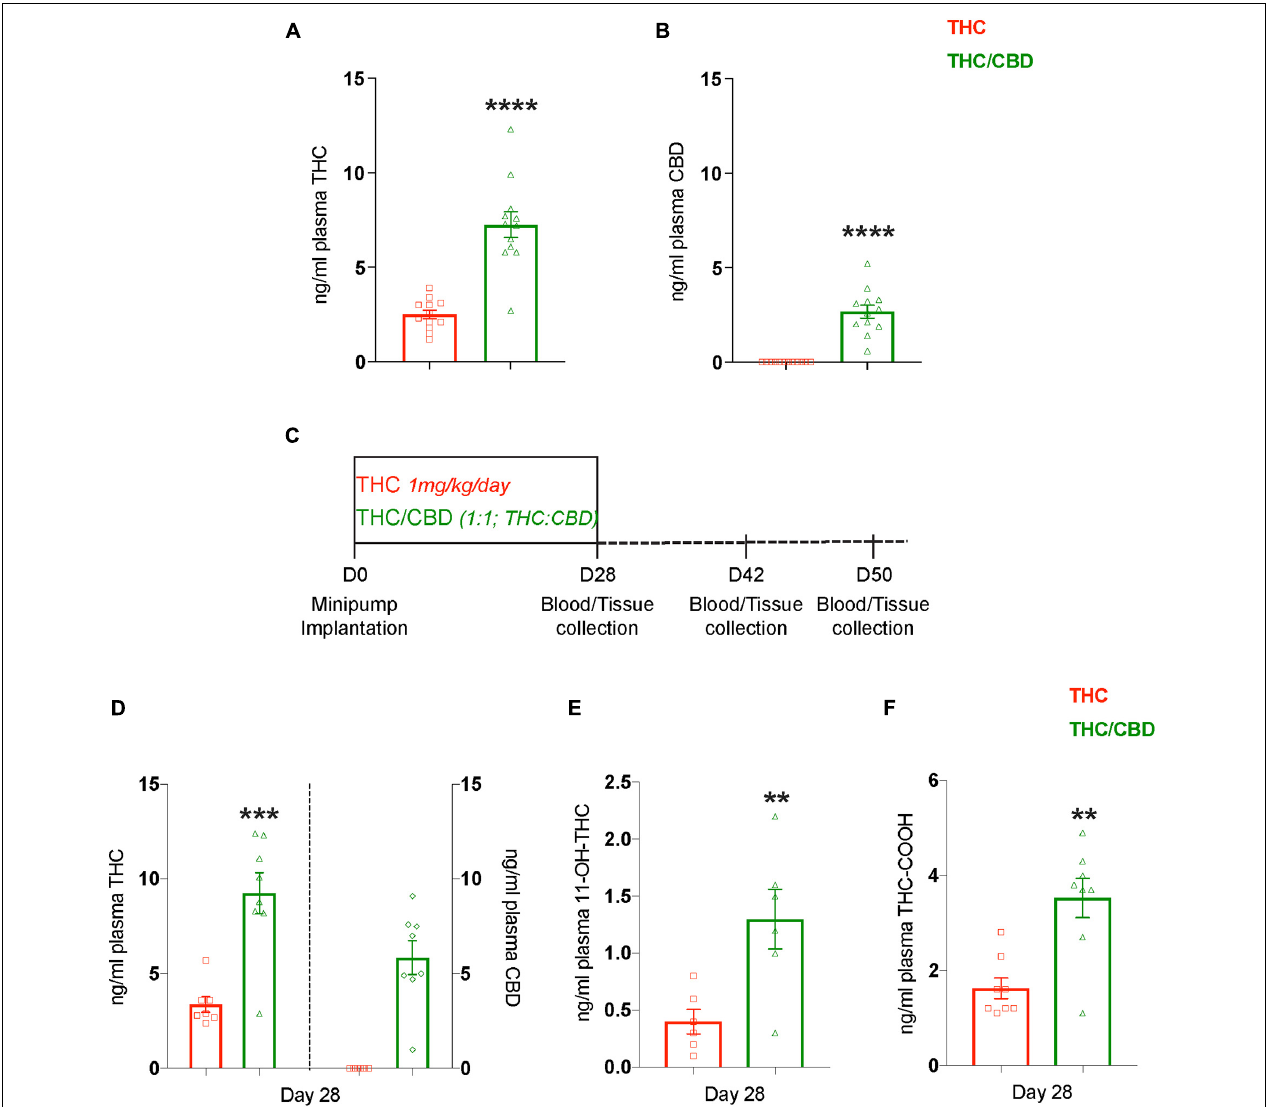
FIGURE 2 | CBD elevates plasma THC levels. (A,B) Plasma concentrations of THC and CBD among the treatment groups measured 2 weeks (day 14) after the pump implantation shows that the presence of CBD elevates plasma THC levels ( n = 12 mice per group). (C) The scheme depicts the time-course paradigm where mice were implanted with pumps on day 0, and tissue collected on day 28 (last day of treatment), day 42 (2 weeks post-treatment cease), and day 50 (3 weeks post-treatment cease). (D) Plasma THC and CBD concentrations measured on day 28 are depicted on left and right Y -axis respectively. Similar to day 14, the plasma THC levels are also elevated on day 28 in the presence of CBD ( n = 7–8 mice per group). (E,F) Determining the concentrations of plasma THC metabolites showed an elevation in 11-OH-THC and THC-COOH in the presence of CBD. THC along with its metabolites, and CBD were not detected in the plasma at days 42 and 50 ( n = 6–8 mice per group). Data represented as mean ± SEM, **** p < 0.0001; *** p < 0.0005; ** p < 0.01; unpaired t